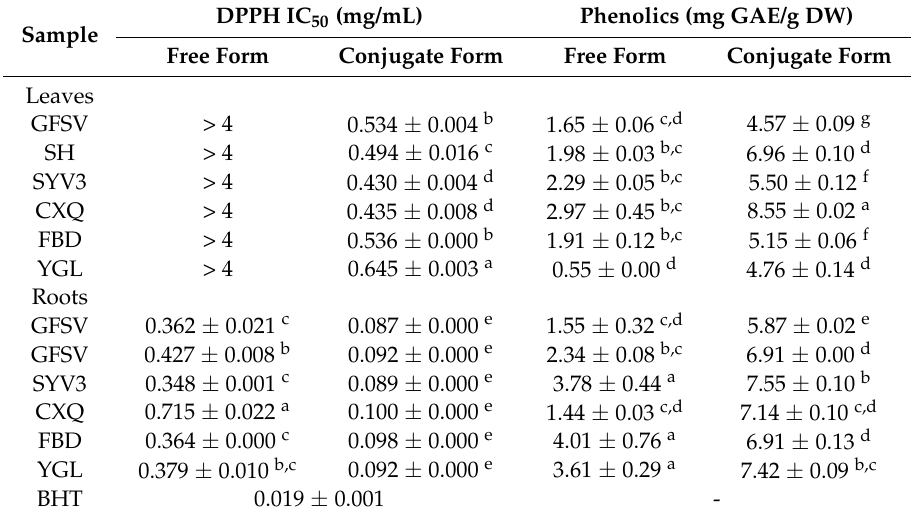
Table 2. DPPH radical scavenging activity in terms of IC 50 values and phenolic contents of Phal. hybrid extracts.